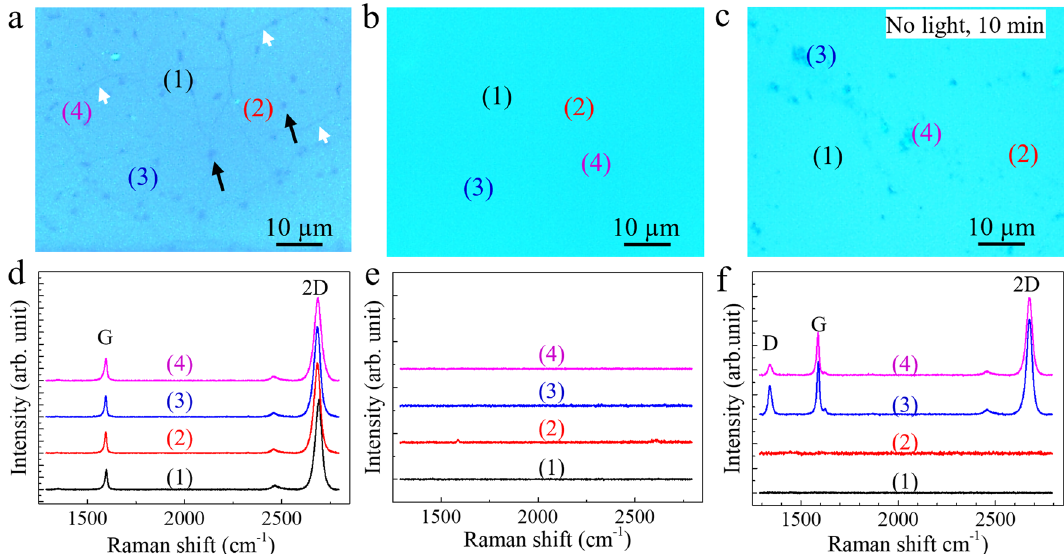
Figure 1. Degradation of graphene by bleach solution (NaClO, 6 wt%). ( a ) Optical microscopy images of monolayer graphene film on SiO 2 /Si substrate. Lines (indicated by white arrows) and dark spot-like areas (indicated by black arrows) represent the domain boundaries and regions with few graphene layers, respectively. Images acquired after treatment with bleach solution assisted by UV light irradiation were captured after 5 min ( b ), and without light irradiation after 10 min ( c ). Raman spectra ( d , e , and f ) for locations (1, 2, 3, and 4) correspond to images ( a , b , and c ),